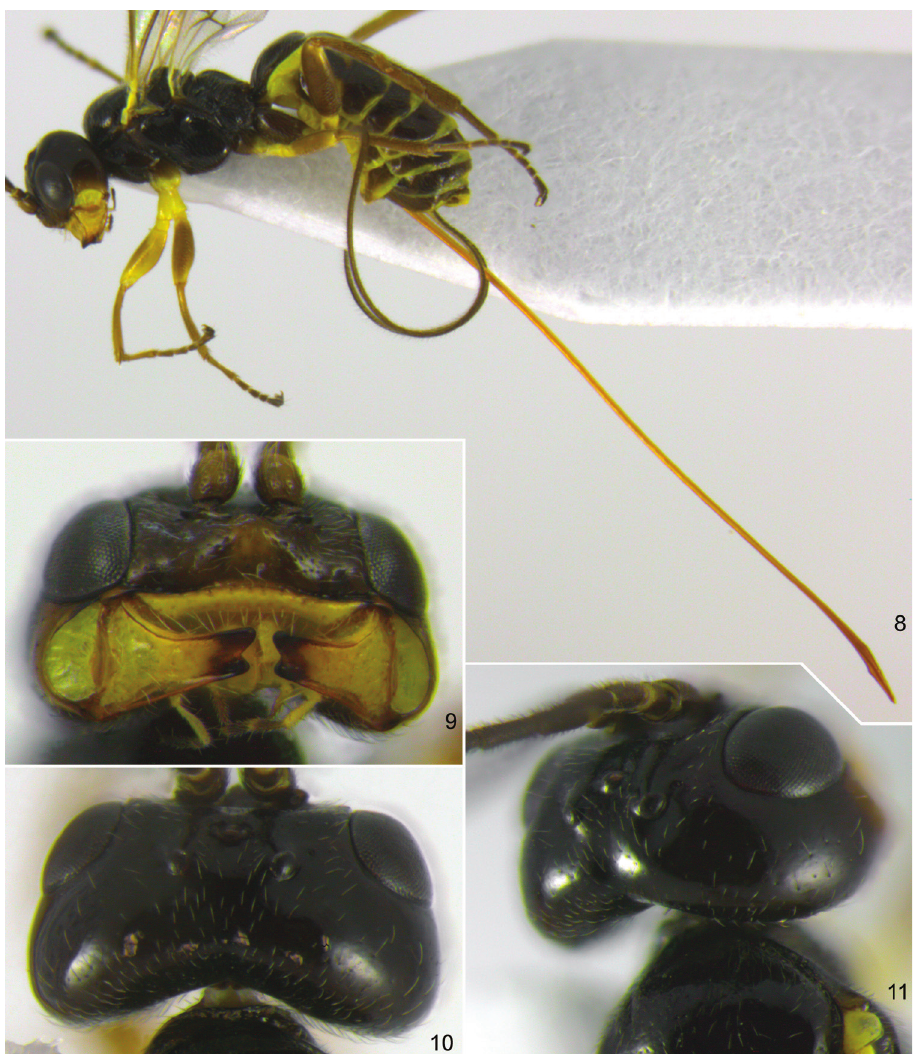
Figures 8–11. Idiogramma elbakyanae sp. n., holotype female 8 habitus (without antennae and